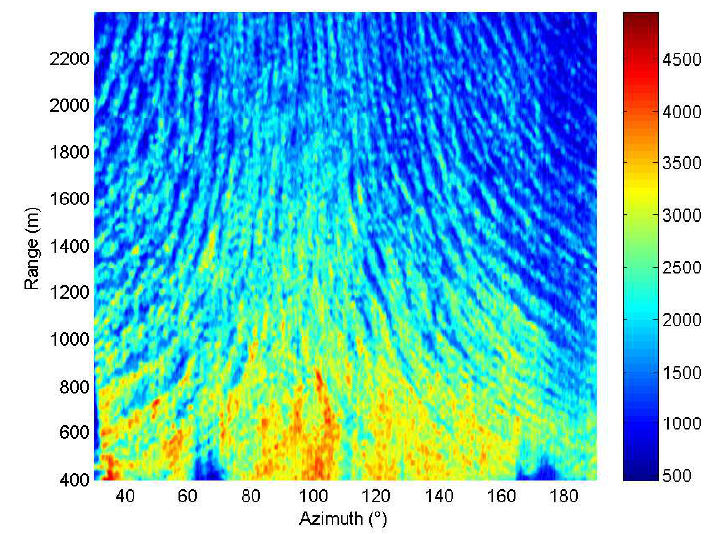
Figure 3. The selected analysis area of radar image in Cartesian coordinate system.